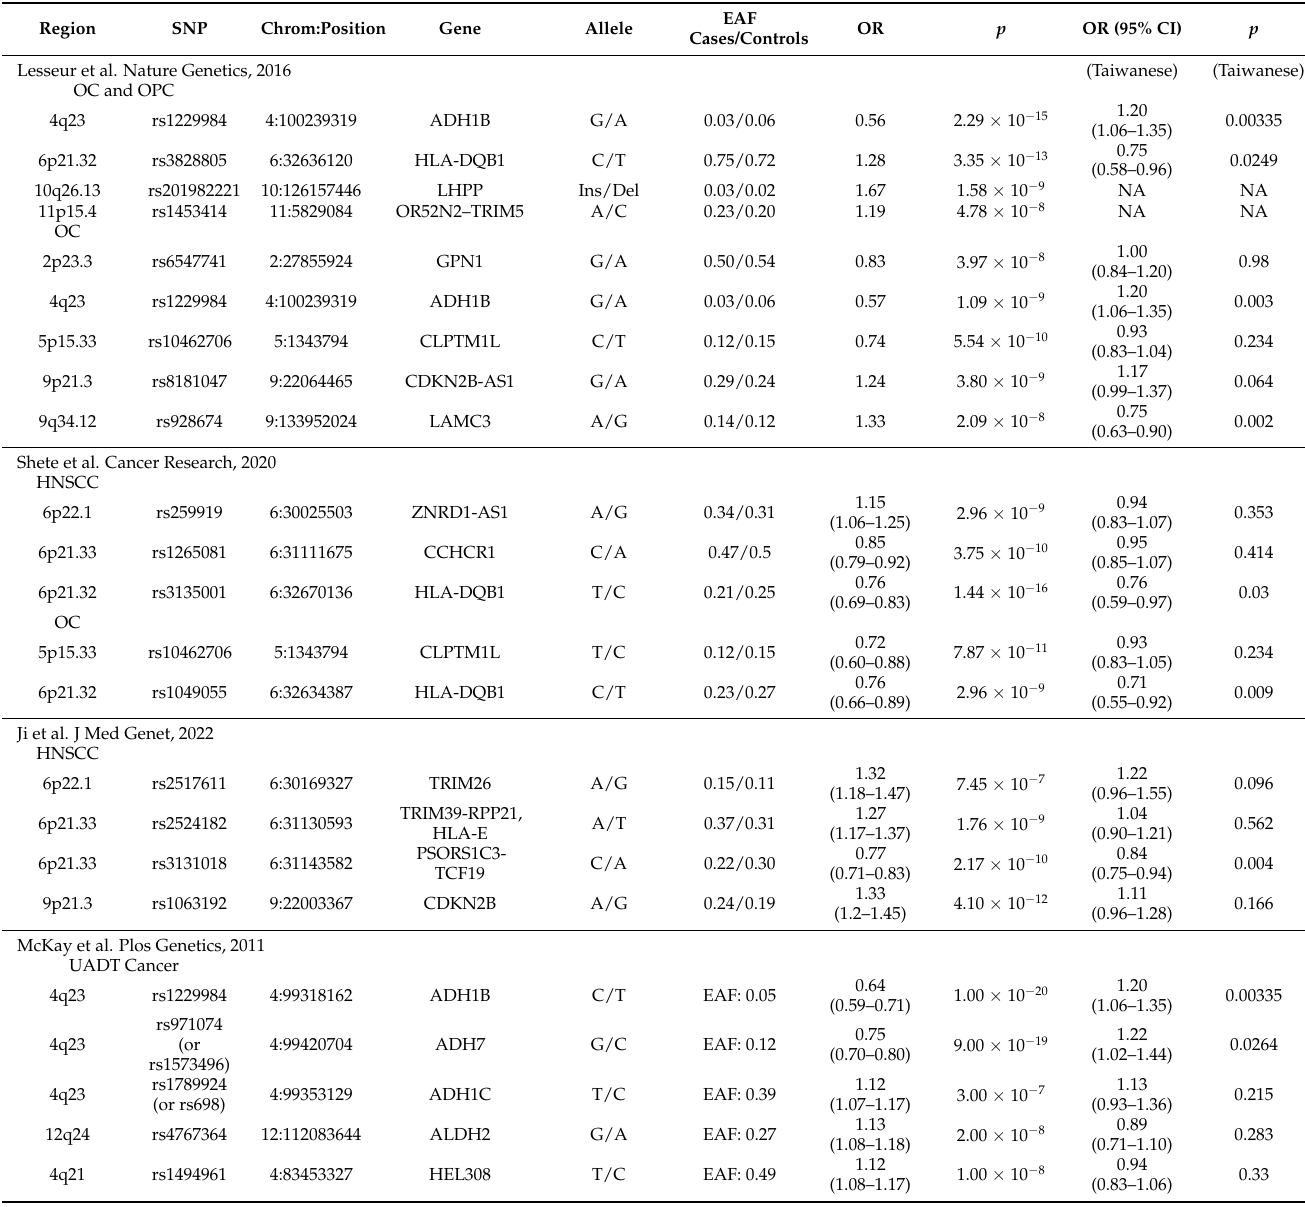
Table 3. Replication of previous GWAS-identified oral cancer susceptibility loci in Taiwan